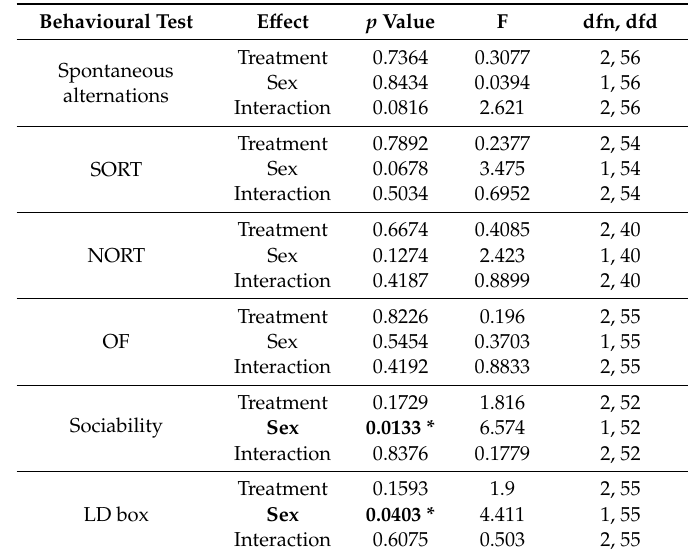
Table 1. Statistical analysis presenting the e ff ect of treatment and sex on the performance in di ff erent behavioral tests (two-way ANOVA). F = f-distribution, dfn = degrees of freedom numerator, dfd = degrees of freedom denominator. * Bold p values represent significant values.